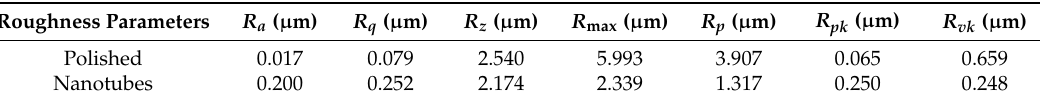
Table 6. The roughness parameters for the Ti35Nb10Ta